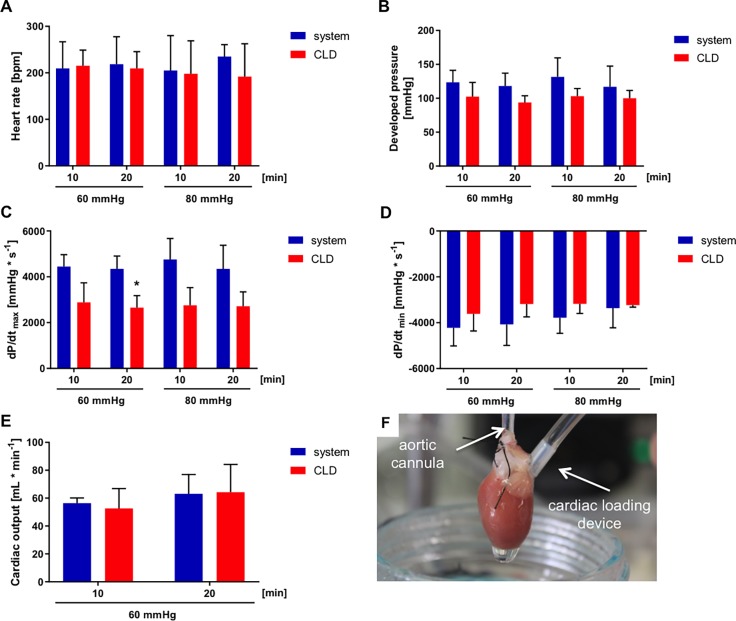
Results of isolated rat hearts.Heart rate (A), developed pressure (B), dP/dtmax (C), dP/dtmin (D), cardiac output (E) with the isolated working rat heart system (system) and our cardiac loading device (CLD), for afterloads of 60 and 80 mmHg. (F) Picture of CLD in an isolated rat heart. Data are expressed as mean ± SD. * p<0.05, n = 3–6 per group.